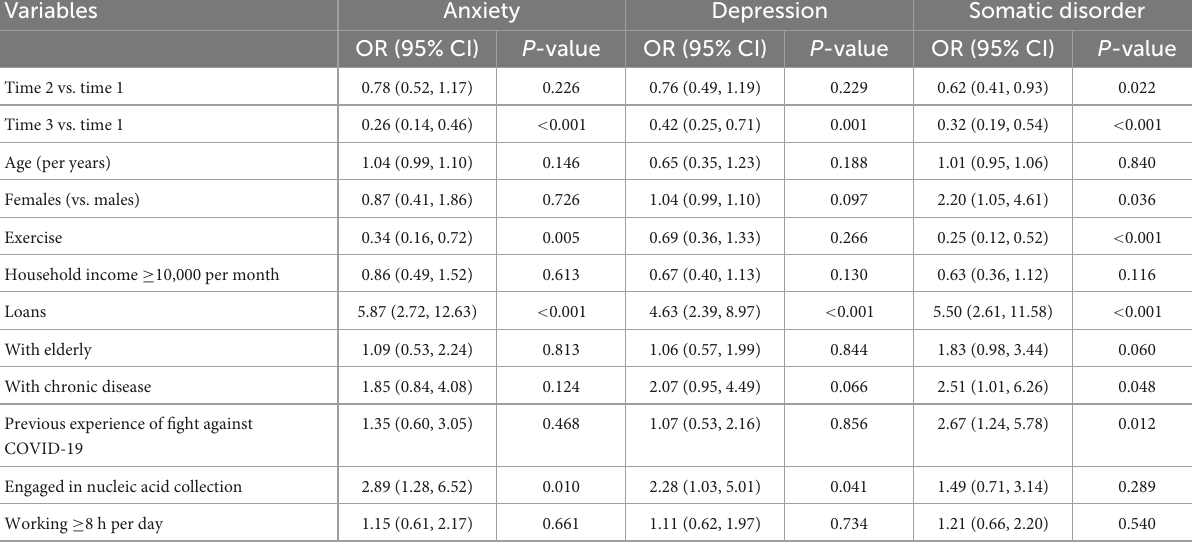
TABLE 3 Correlation between independent variables and anxiety, depression, and somatic disorder estimated by generalized estimation equation. Variables Anxiety Depression Somatic disorder OR (95% CI) P- value OR (95%